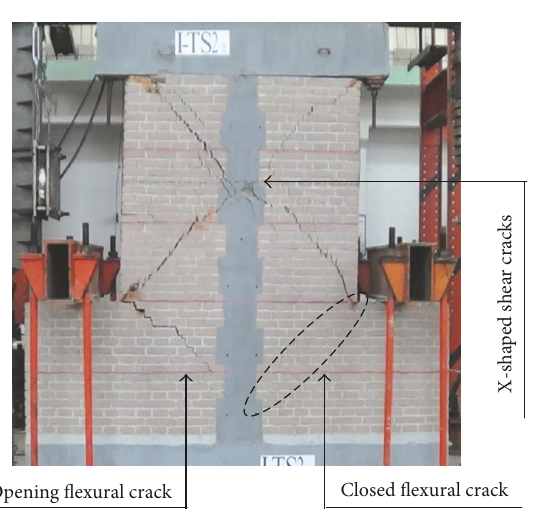
Figure 12: Failure photographs of the specimen